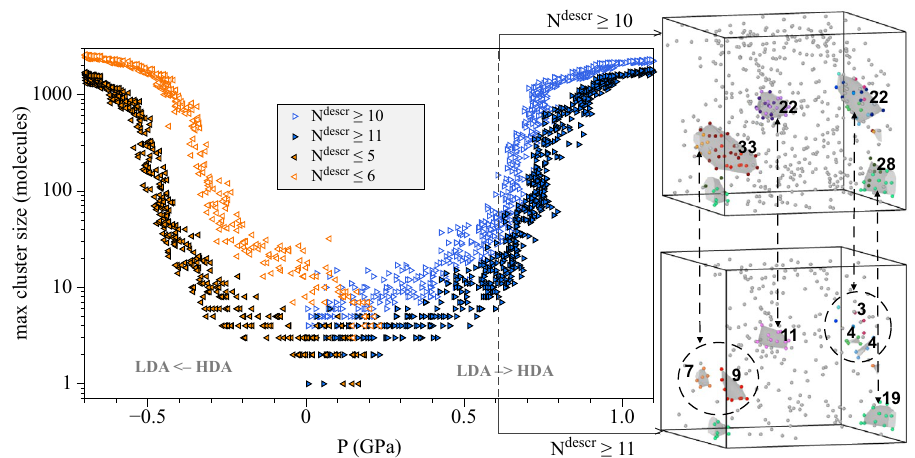
Figure 8. Pressure-induced LDA ↔ HDA transformations at T = 77 K . The pressure dependence of the size of descr the largest cluster defined according to our algorithm for two variants of the threshold values of N for LDA/ HDA selection. Two snapshots show several HDA clusters at the moment corresponding to P = 0.61GPa . descr (cid:31) 11 The lower snapshot shows the oxygen atoms with N (the largest cluster has 19 molecules), seven HDA-clusters are highlighted by the color and the surface mesh (a number next to a cluster indicates how many descr (cid:31) 10 molecules it contains). The top snapshot for the same time moment shows the oxygen atoms with N (the largest cluster has 33 molecules) and the HDA-clusters that includes the clusters shown on the lower snapshot (additional atoms are highlighted in dark